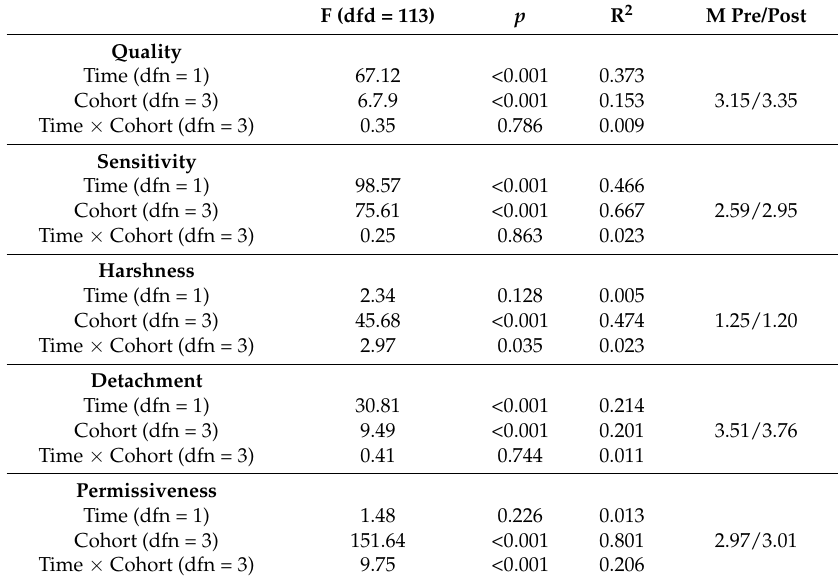
Table 2. The Effects of Time, Cohort, and Time × Cohort on Arnett Caregiver Interaction Scale (CIS). F (dfd = 113) p R 2 M